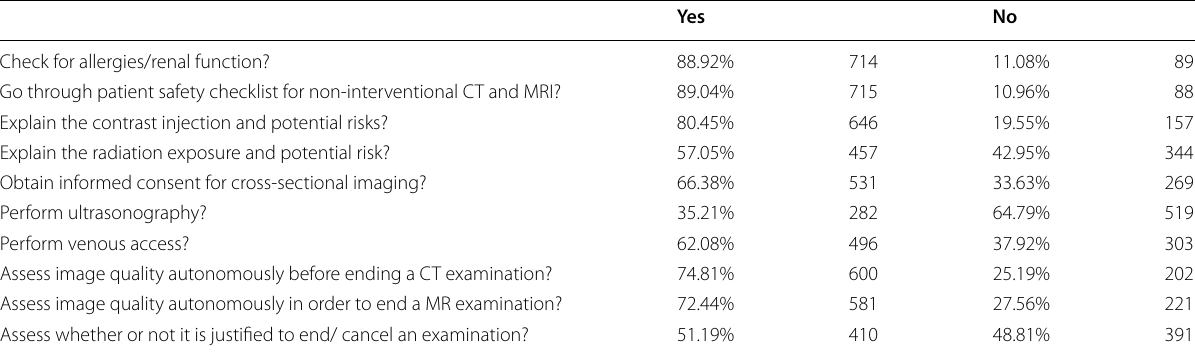
Table 4 In your department do radiographers typically: (responses n